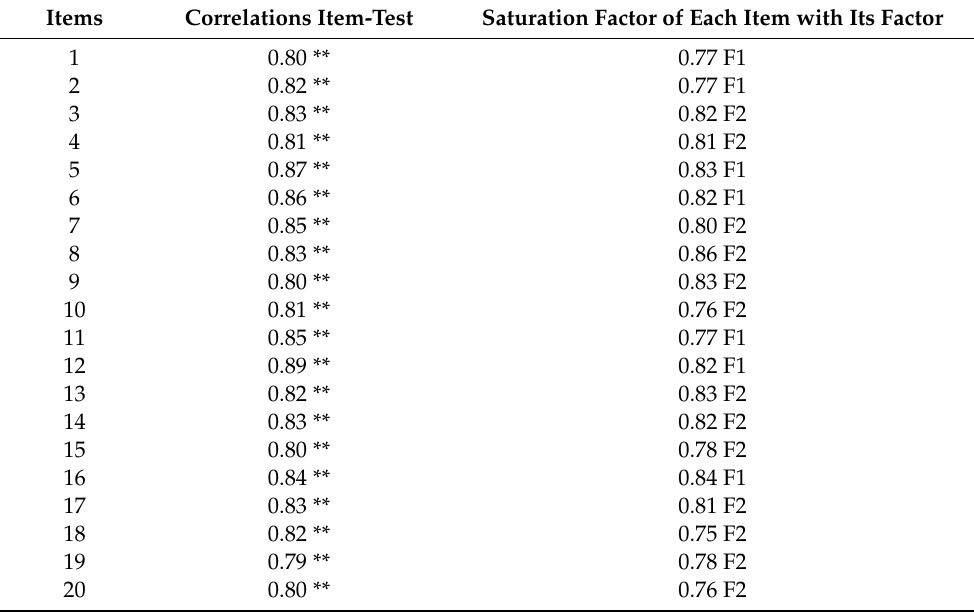
Table 1. Correlations between each item and the total scale